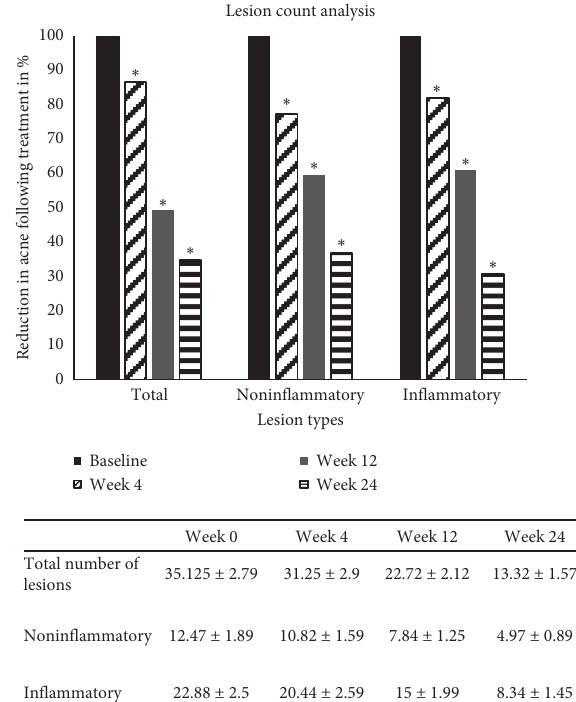
Figure 2: Quantitative analysis indicating percentage reduction in acne lesions. Lesion counts of total acne including the inflam- matory and the noninflammatory types at week 0 (100%), 4, 12, and 24 are represented. ∗ Statistical significance of P < 0 . 05, based on Student’s t -test. The table provides the corresponding values as average ±